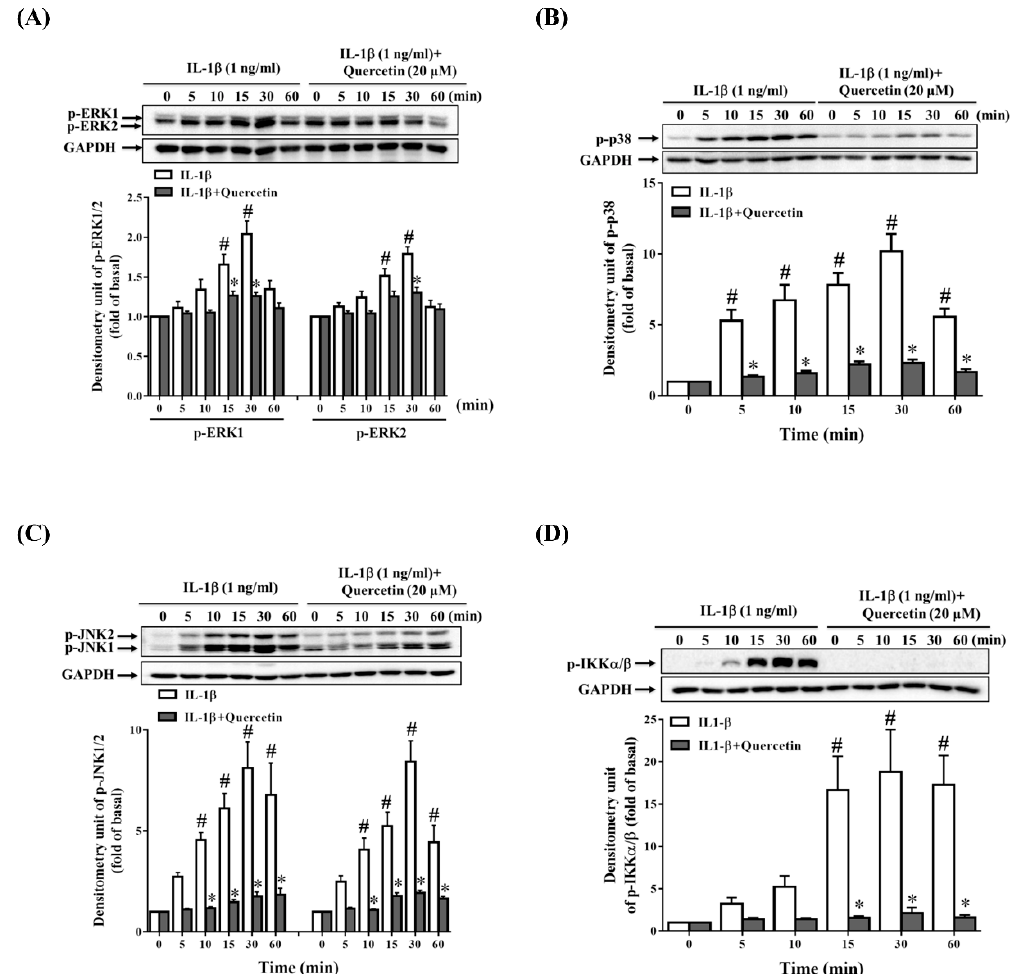
Figure 4. Quercetin inhibits the phosphorylation of mitogen-activated protein kinases (MAPKs) and inhibitor of nuclear factor κ -B kinase (IKK) α / β in IL-1 β -stimulated ARPE-19 cells. ARPE-19 cells were treated with 20 µ M quercetin for 1 h prior to the stimulation with 1 ng / mL IL-1 β for the indicated time. Western blotting and Image Lab software were used to analyze and quantify the phosphorylation of ( A ) extracellular signal-regulated kinase (ERK) 1 / 2, ( B ) p38, ( C ) c-Jun N-terminal kinase (JNK) 1 / 2 and ( D ) IKK α / β . The data are expressed as mean ± SD of three independent experiments. # p < 0.05 versus control cells. * p < 0.05 versus IL-1 β -stimulated cells.